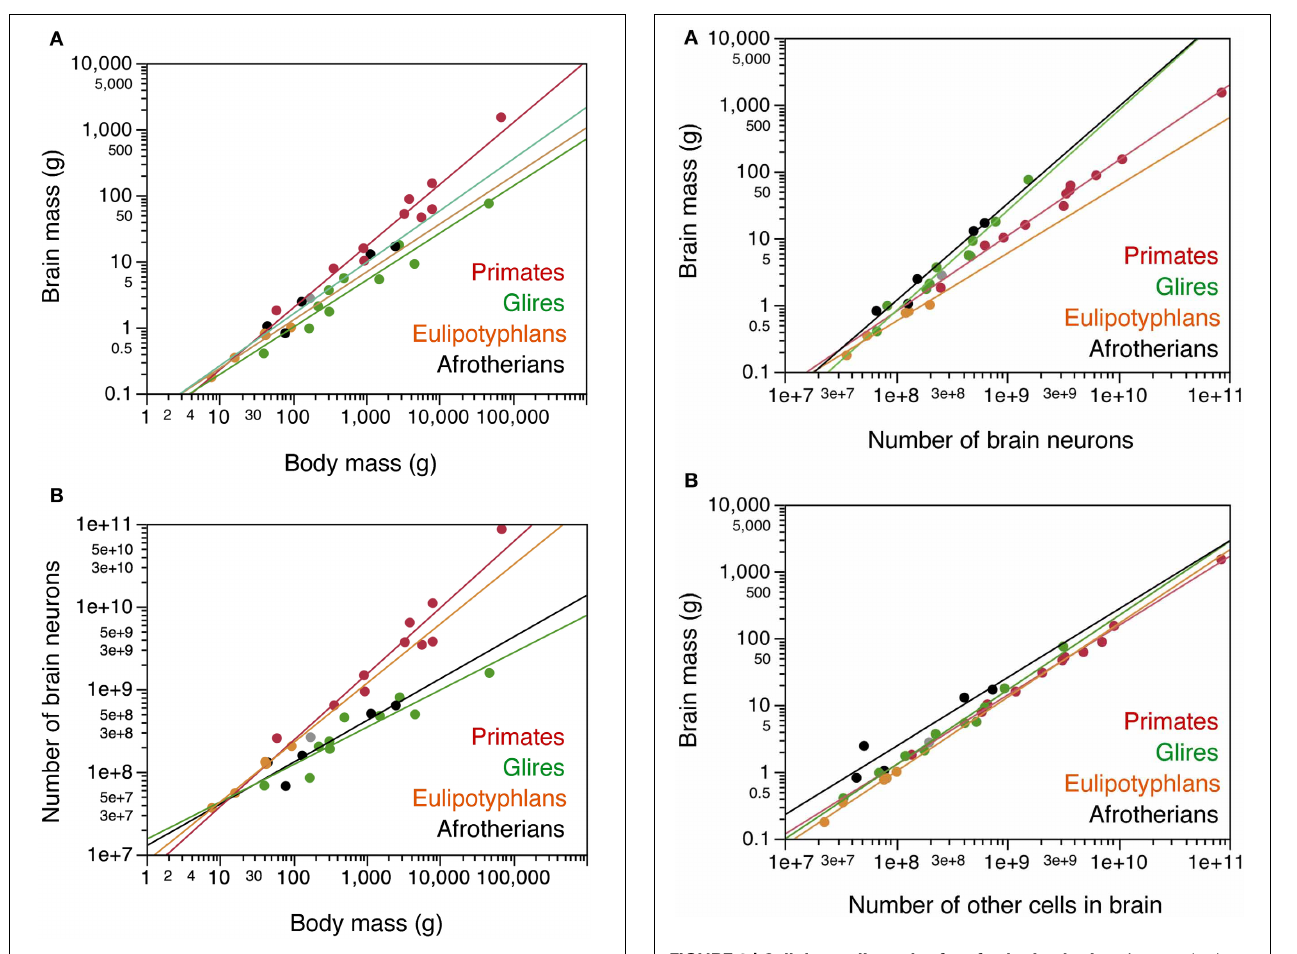
FIGURE 3 | Cellular scaling rules for afrotherian brains. Average brain mass for each species is plotted as a function of its total number of neurons (A) or other, non-neuronal cells in the brain (B) . Brain does not include olfactory bulb. Afrotherian species shown in black, primates in red, scandentia in gray, glires in green, and eulipotyphlans in orange. Data from Herculano-Houzel et al. (2006, 2007, 2011); Azevedo et al. (2009); Sarko et al. (2009); Gabi et al. (2010). Power functions for each group are plotted. Exponents for brain mass × numbers of neurons are 1.451 ± 0.163 (afrotherians), 1.499 ± 0.107 (Glires), 1.016 ± 0.108 (eulipotyphlans), 1.130 ± 0.036 (primates with Scandentia). Exponents for brain mass × numbers of other cells are 1.025 ± 0.218 (afrotherians), 1.114 ± 0.049 (Glires), 1.105 ± 0.082 (eulipotyphlans), 1.040 ± 0.020 (primates with